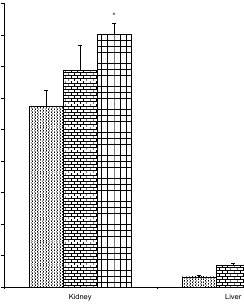
Figure 3. Effect of administration of ligands and metal complexes on the activities of alanine amino transferase (ALP) of rat serum, kidney and liver. * Significantly different from the control (p<0.05).